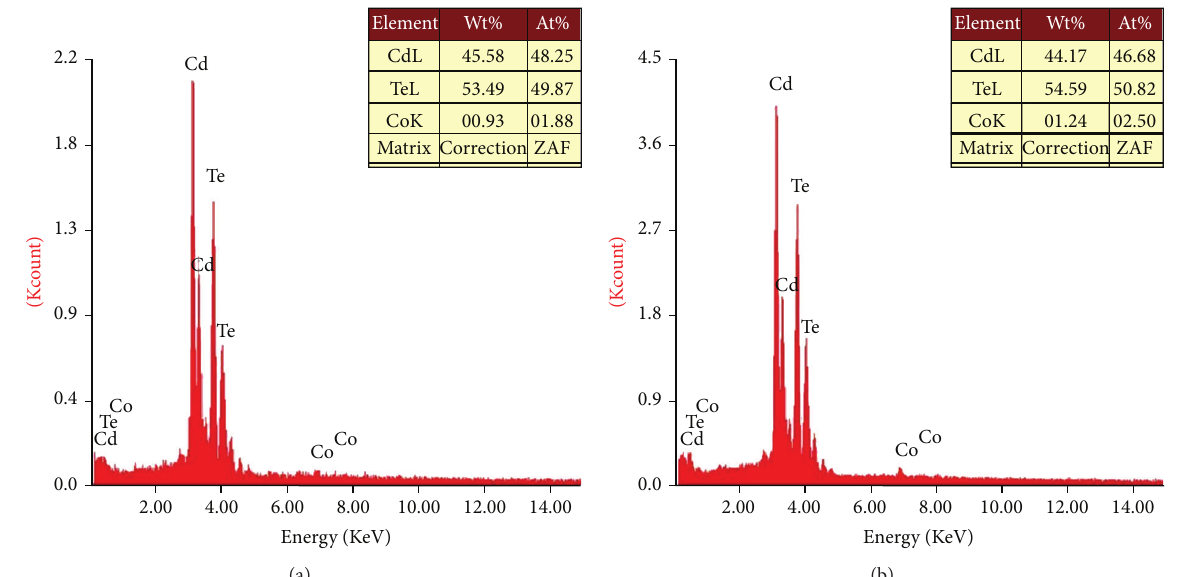
Figure 3: EDAX spectra of (a) Cd 0.95 Co 0.05 Te and (b) Cd 0.92 Co 0.08 Te alloy powders.